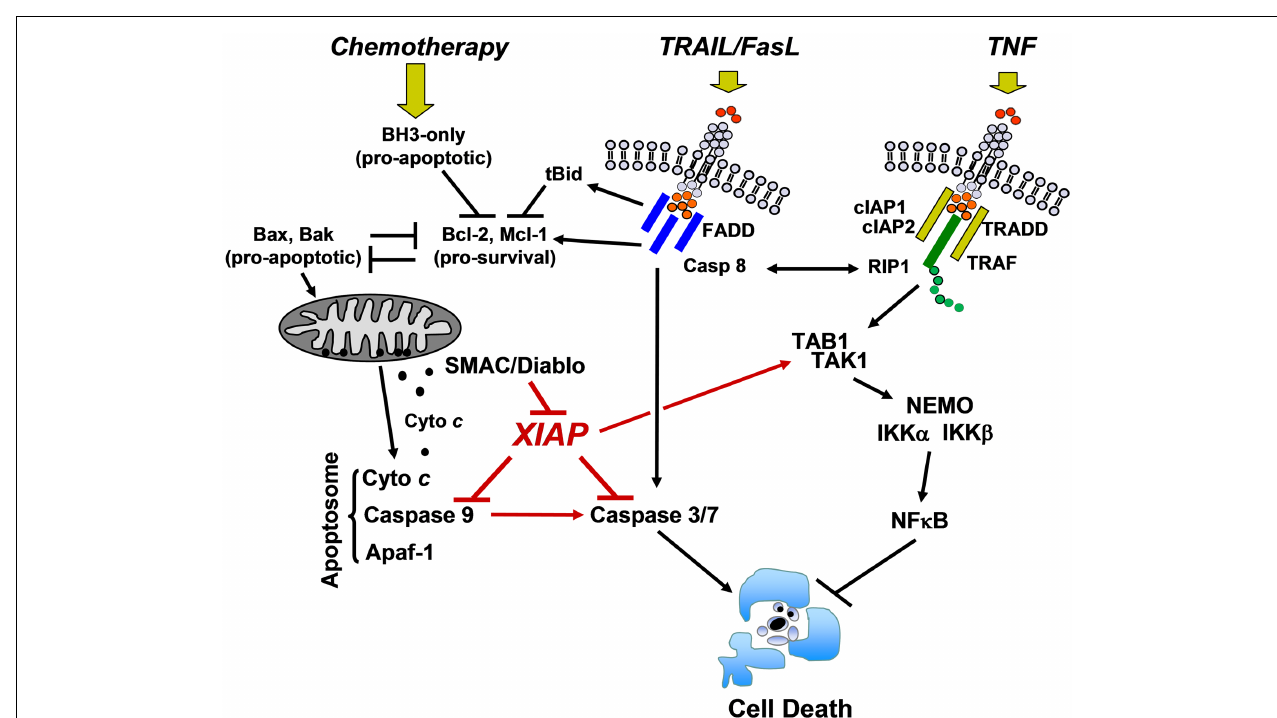
caspases-3 and -7 via caspase-8 directly or trigger mitochondrial cell death via caspase-8-mediated cleavage of BID and MCL1. XIAP physically interacts with caspase-9 at its BIR3 domain and with caspase-3 and -7 at its BIR2 domain and thereby interferes with both death signaling pathways. In contrast,TNF triggers a signaling cascade that, if RIP1 is ubiquitylated by cIAP1 and cIAP2, induces NF κ B activation viaTAK1/TAB1 and subsequent IKK α /IKK β